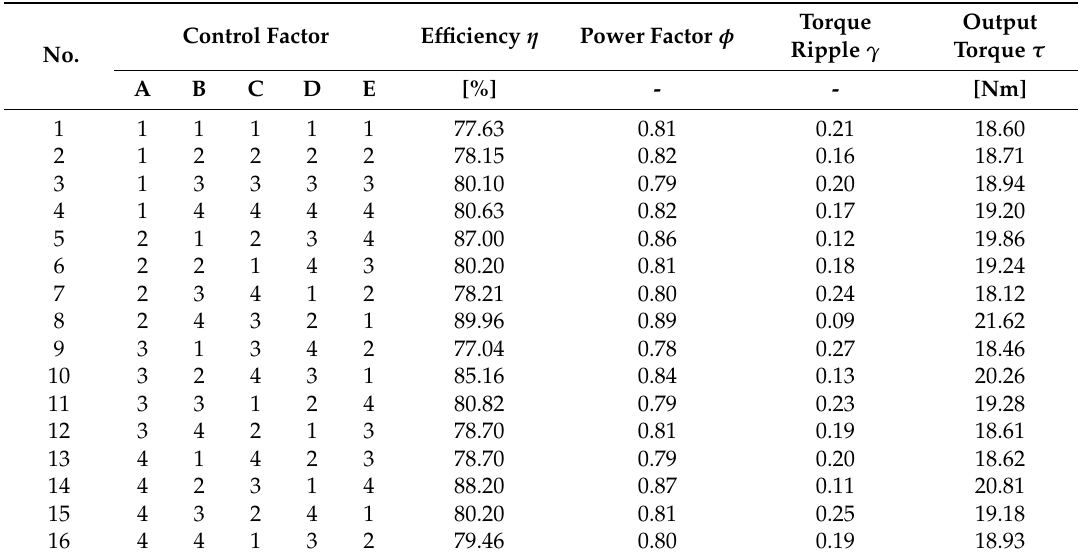
Table 2. Orthogonal array (OA) L16 matrix by using Taguchi method and experimental results.